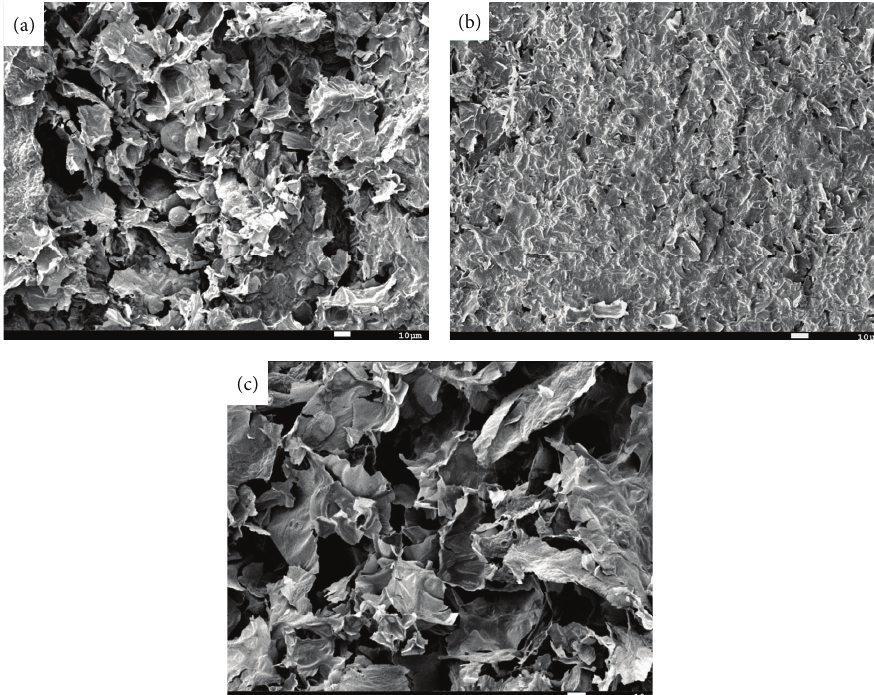
Figure 6: SEM images for the char residues of PP/27%IFR systems with and without PETA: (a) PP/27%IFR, (b) PP/27%IFR/3%PETA, and (c)